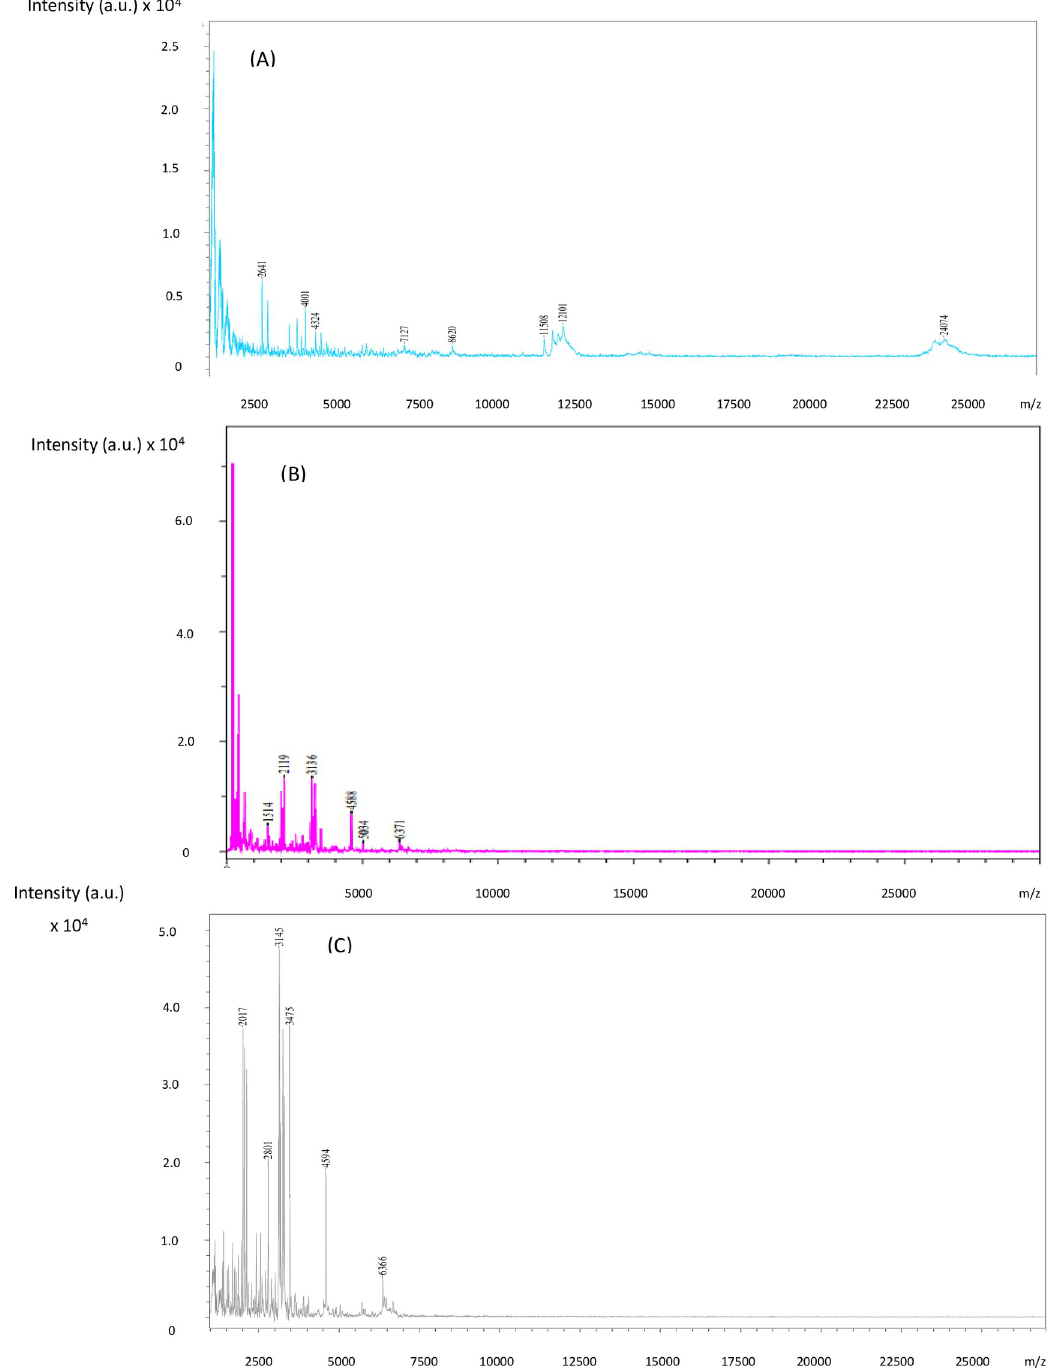
Fig 3. MALDI mass spectra analysis of dissolved milk powder before and after different treatments (a) No treatment; milk powder: water = 1:5 (w/v). (b) VFD-enzymatic hydrolyzation; milk powder: water = 1:5 (w/v); temperature at 55˚C; processing time of 20 mins; VFD speed at 8000 rpm; VFD tilt angle at 45˚. (c) Conventional enzymatic hydrolyzation; milk powder: water = 1:5 (w/v); temperature at 55˚C; processing time of 20